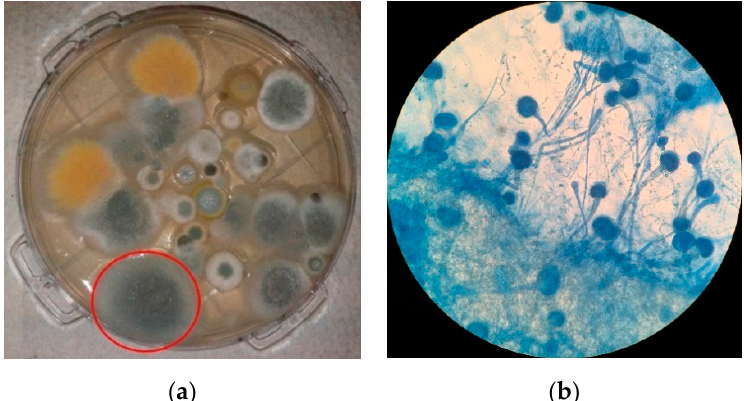
Figure 1. Isolation of Aspergillus from air samples: ( a ) Example of a culture media plate resulting from the collection of indoor air by impaction, and from where Aspergillus section Fumigati (circled red) was isolated; ( b ) Example of a microscopic (400×) observation of a lactophenol blue mount of an A. fumigatus isolate.